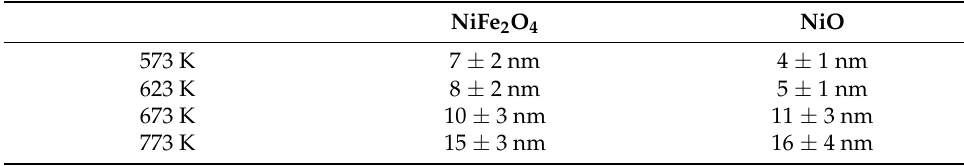
Table 1. Mean particle sizes of the identified phases based on XRD